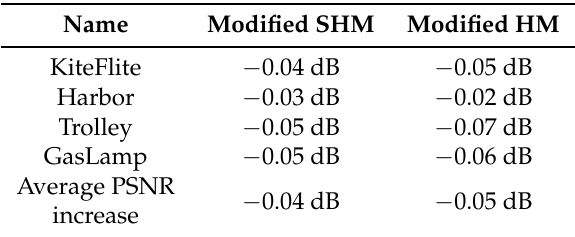
Table 6. PSNR decrease compared to the original encoding.